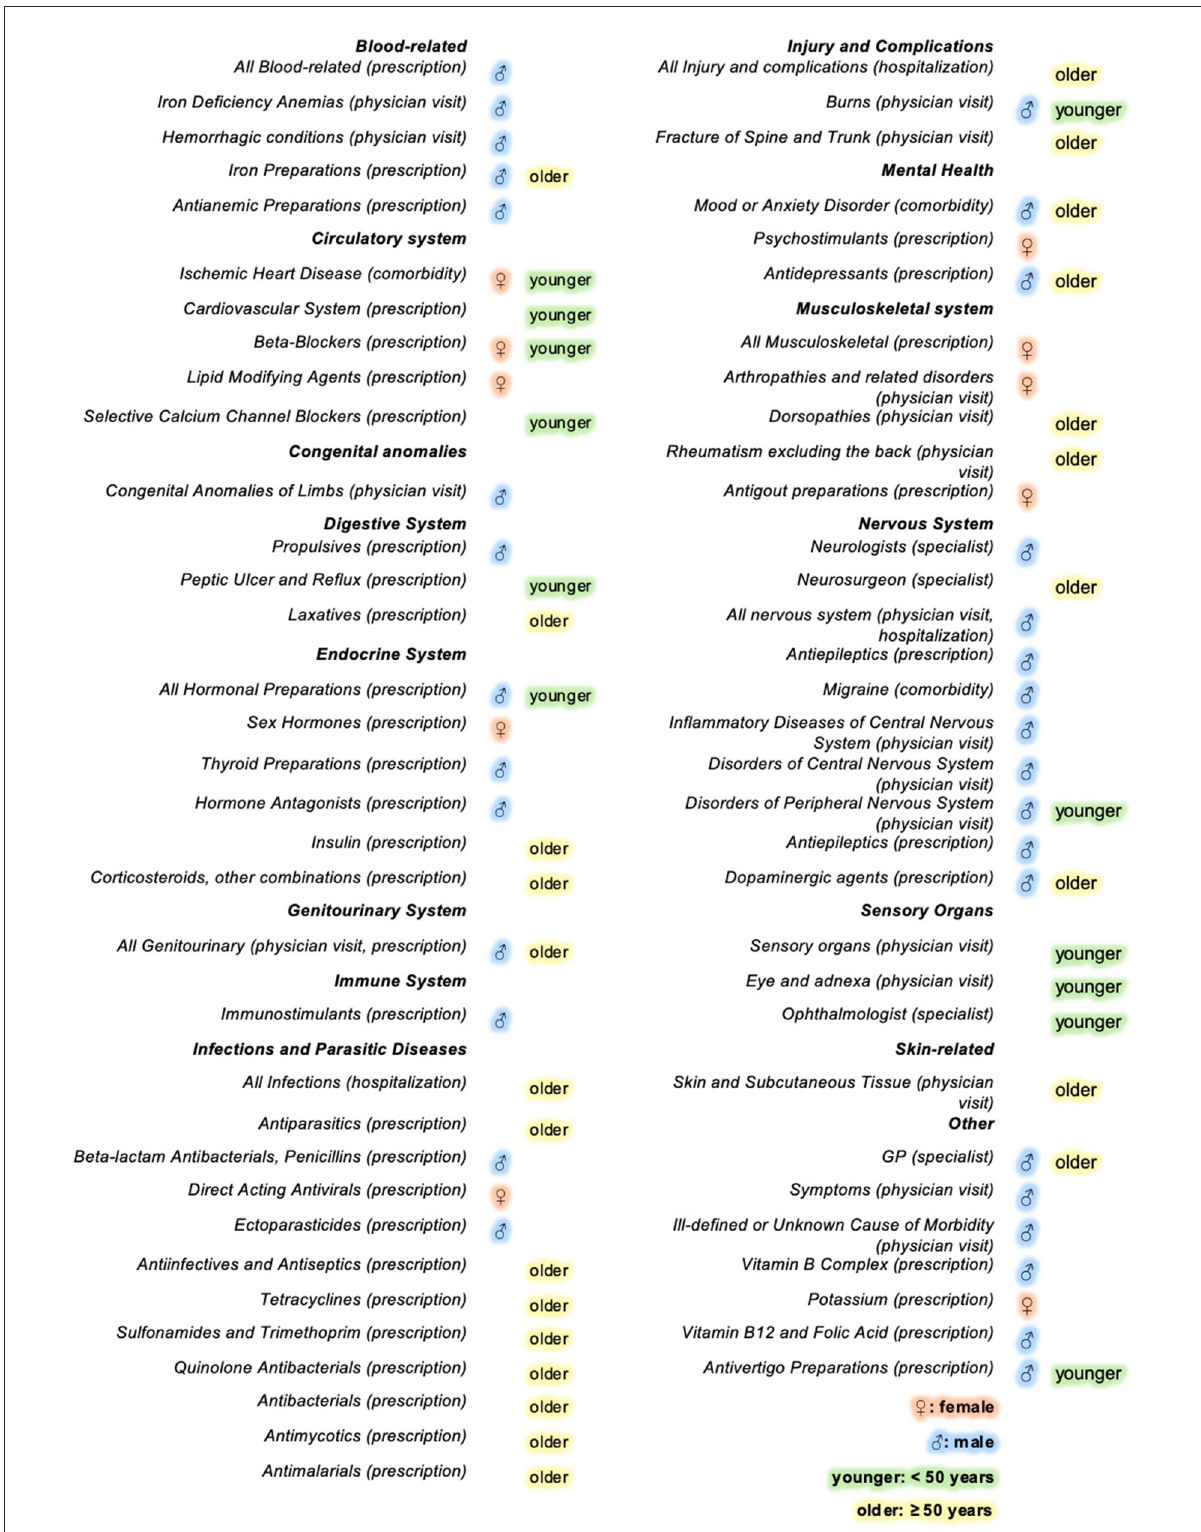
FIGURE3 Infographic summarizing the sex and age differences in health-care use in the 5 years preceding a first demyelinating event, grouped by the main condition or body system affected †‡ . The infographic depicts all the significant findings for the hospitalizations, physician visits,